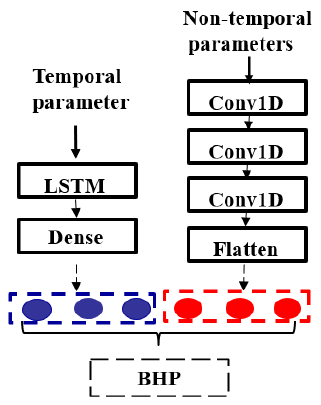
Figure 4. BP-LSTM parallel network structure.